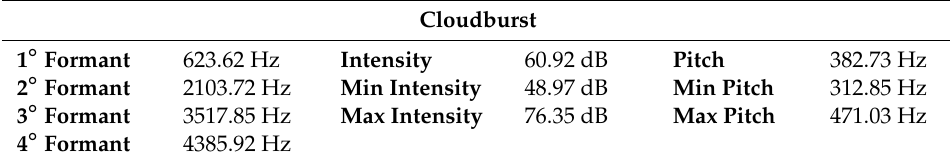
Table 6. Formants, intensity and pitch parameters of “Cloudburst” rain audio signal.